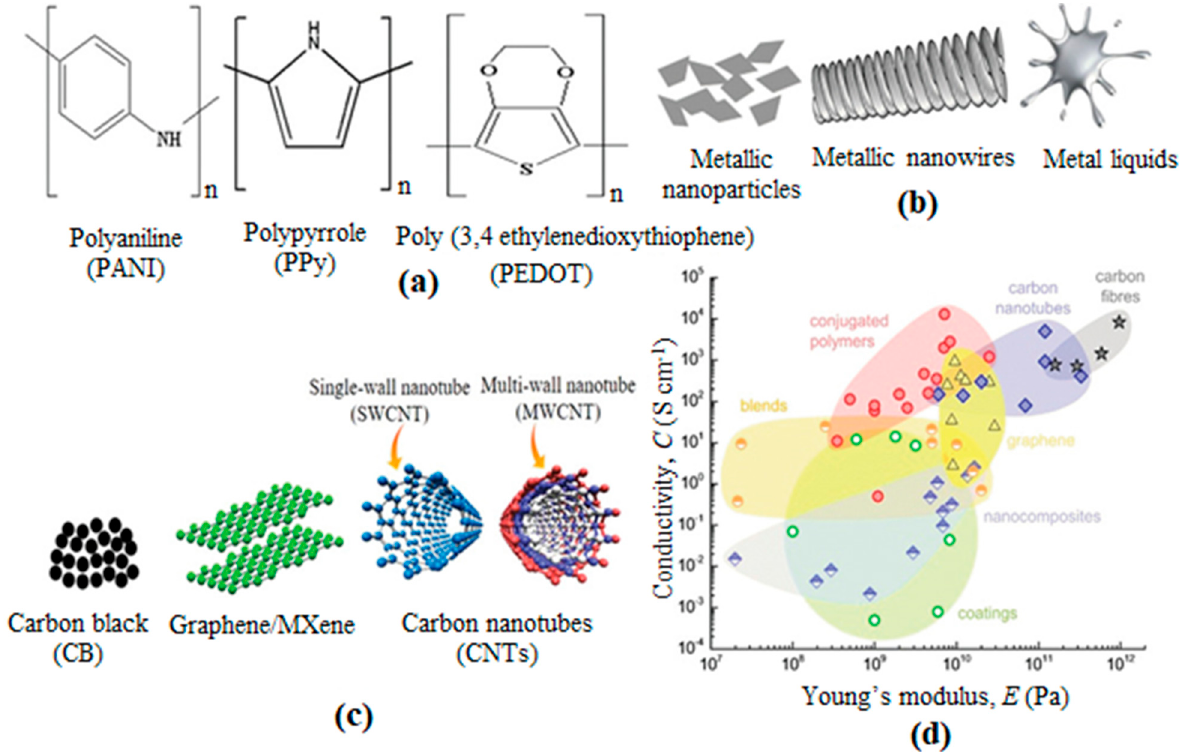
Figure 1. ( a ) Polymeric, ( b ) metallic, and ( c ) carbon-based electroactive materials for e-textiles. ( d ) Electrical conductivity vs. Young’s modulus of different electroactive fibres based on CNTs (blue diamonds), carbon fibers (gray stars), ICPs (red circles), blends of conjugated and insulating polymers (orange/white circles), graphene (yellow triangles), nanocomposites of CB (blue/white diamonds), CNTs or graphene embedded in an insulating polymer matrix and (green/white circles) coatings of textile fibers with ICPs, CNTs, or graphene [27].